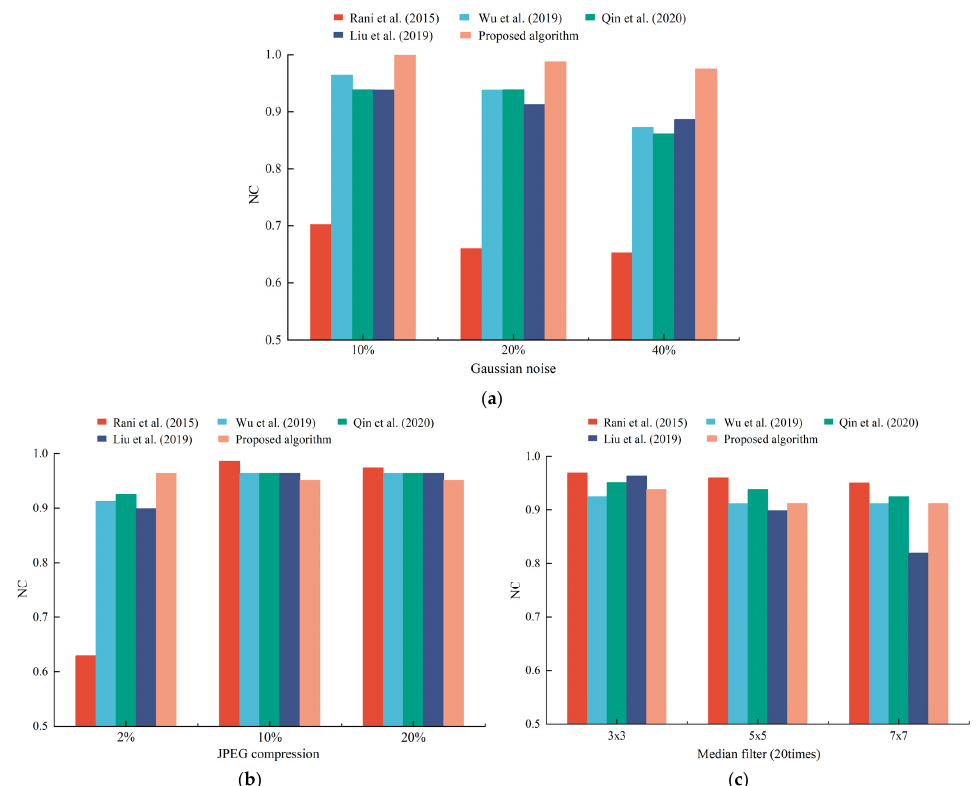
Figure 16. Comparison of the robustness of different algorithms under common attacks: ( a ) Gaussian noise; ( b ) JPEG compression; and ( c ) median filtering.